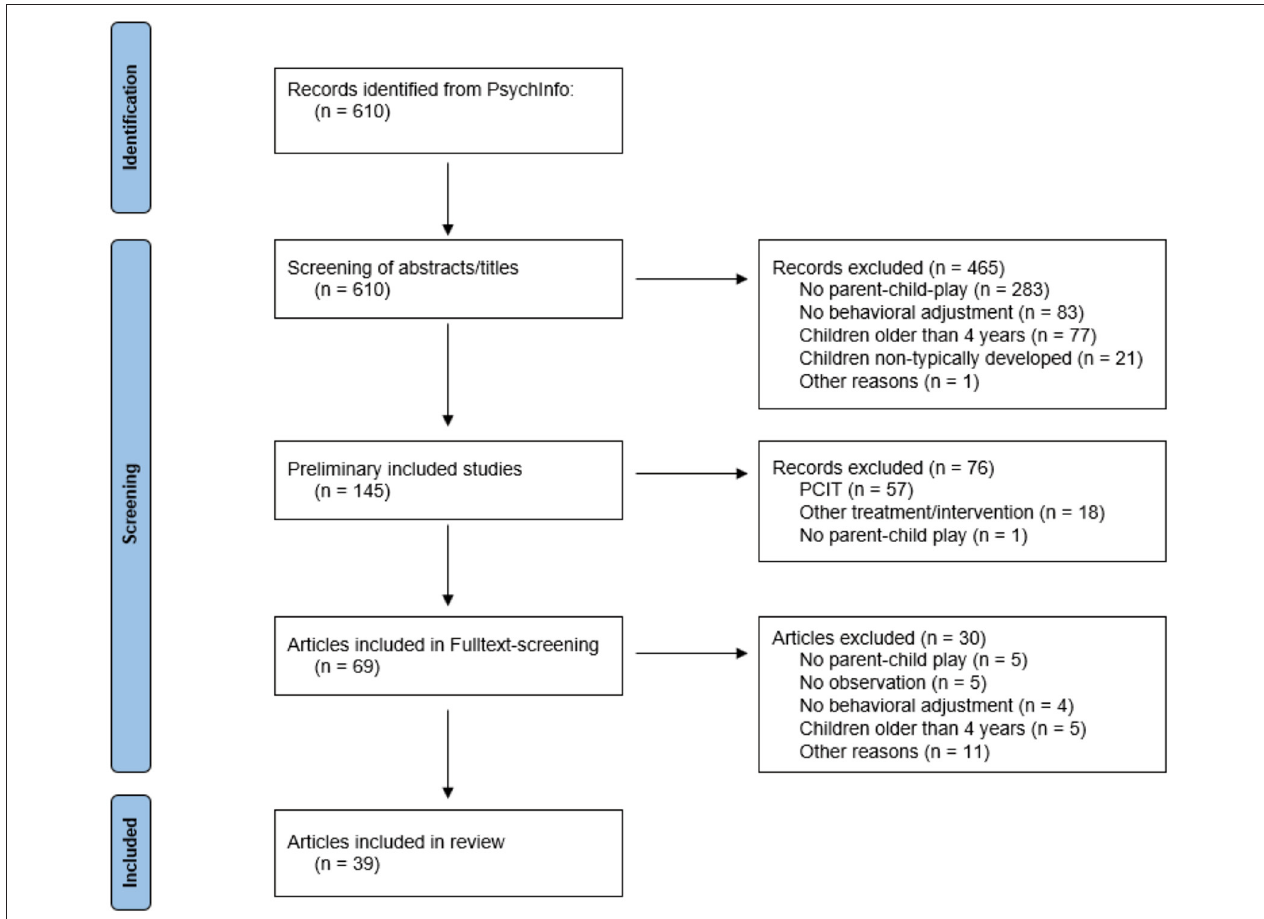
FIGURE 1 | Flow chart describing literature search with number of included and excluded